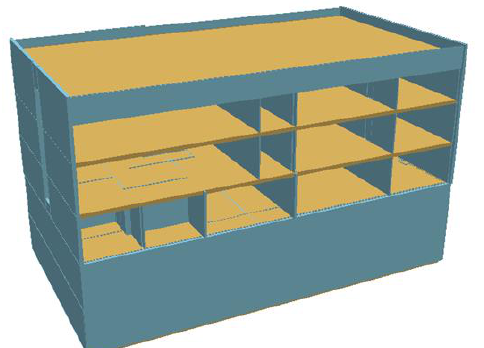
Figure 5 : the resulted building after removing the non-floor surface areas